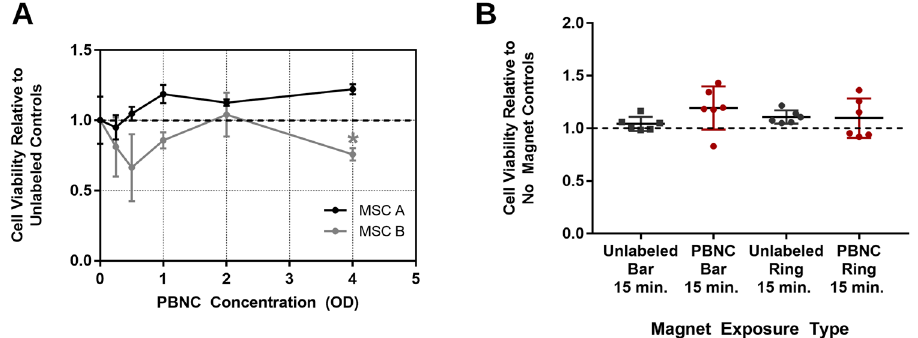
Figure 6. Cell Viability Results for MSCs labeled with 200 nm PBNCs. (A) Relative viability 1 day after 200 nm PBNC labeling for 2 MSC donor strains as determined by flow cytometry (n = 3 technical replicates for each OD). (B) Relative viability of MSCs after magnet exposure for 15 minutes. Bar and Design II ring magnets were placed adjacent to unlabeled and 200 nm PBNC-labeled cells in suspension. Individual data points for each group are shown with horizontal lines indicating means (n = 6 technical replicates for each condition). Error bars denote standard deviation. Asterisks denote significant difference (p < 0.05) compared to unlabeled controls as determined by ANOVA, with Dunnett’s post hoc